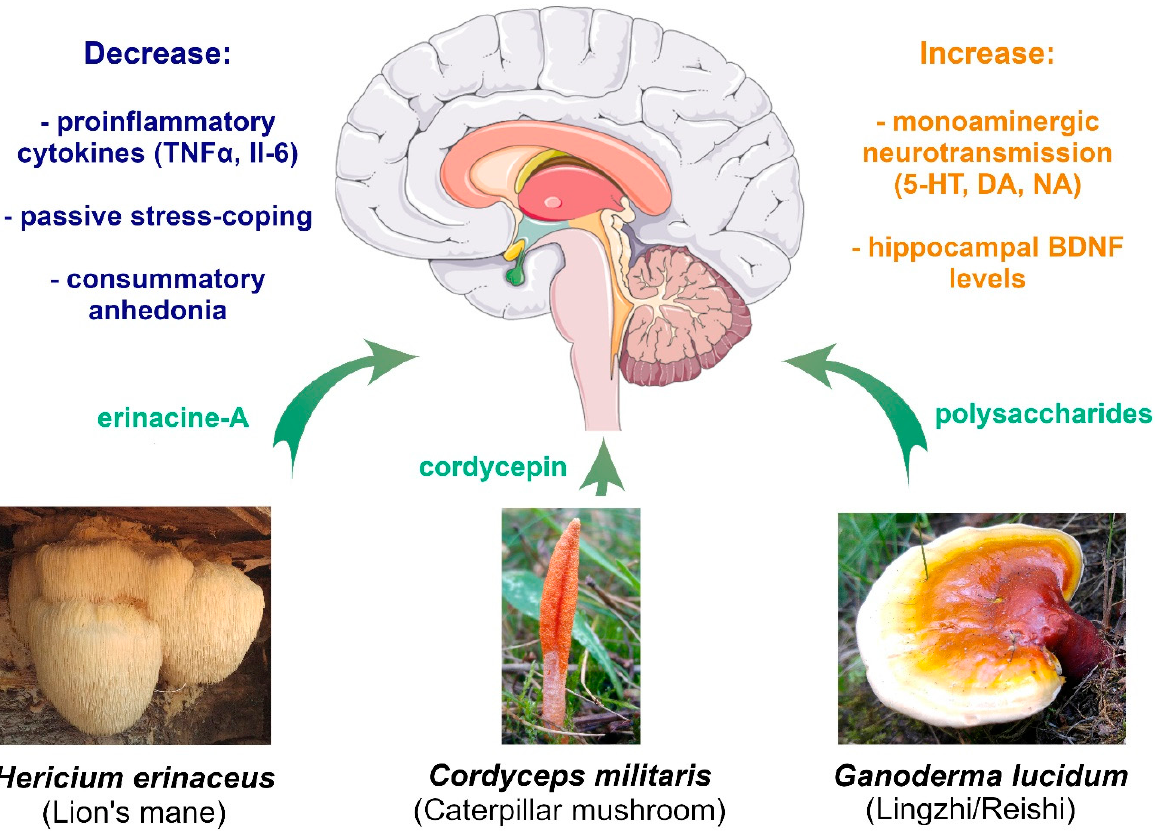
Figure 4. Common neurobiological mechanisms and behavioral effects observed in chronic stress rodent models of MDD after supplementation with compounds from Hericium erinaceus , Cordyceps militaris or Ganoderma lucidum (Figure composed using Servier Medical Art: http://smart.ser- vier.com/(accessed on 15 May 2022)). Photos were kindly provided by Pawe ł Stasiowski.